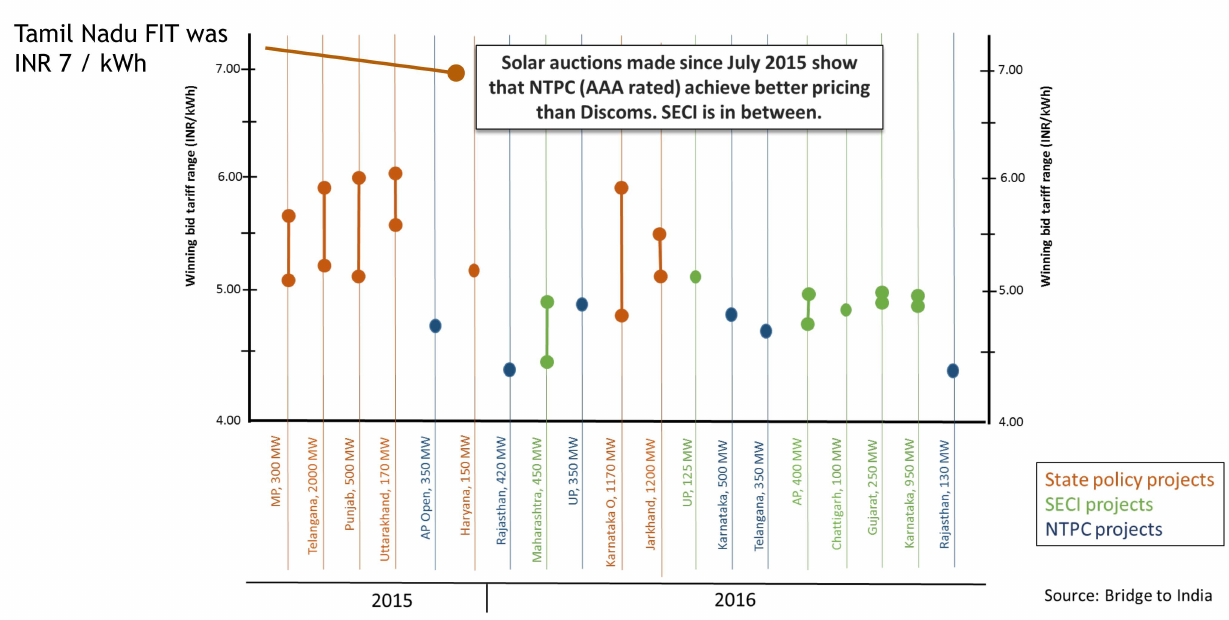
Figure 2. Auction prices at recent